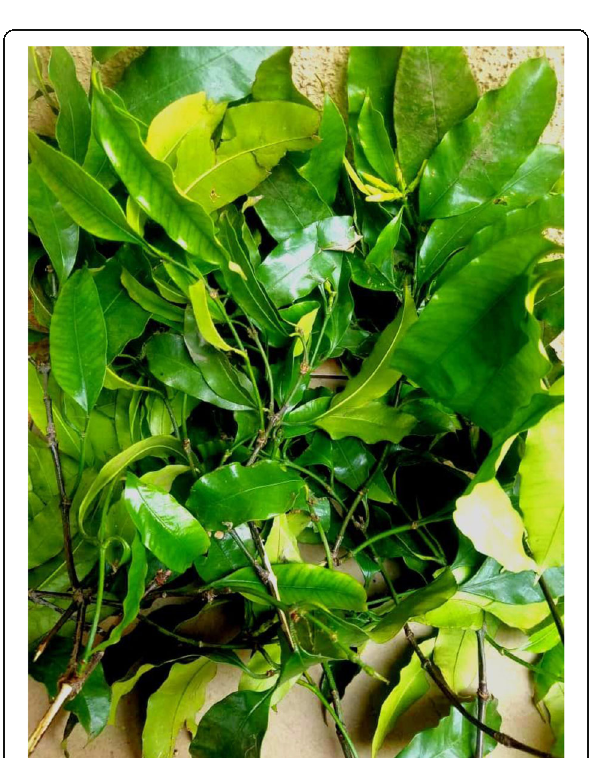
Fig. 3 H. umbellate